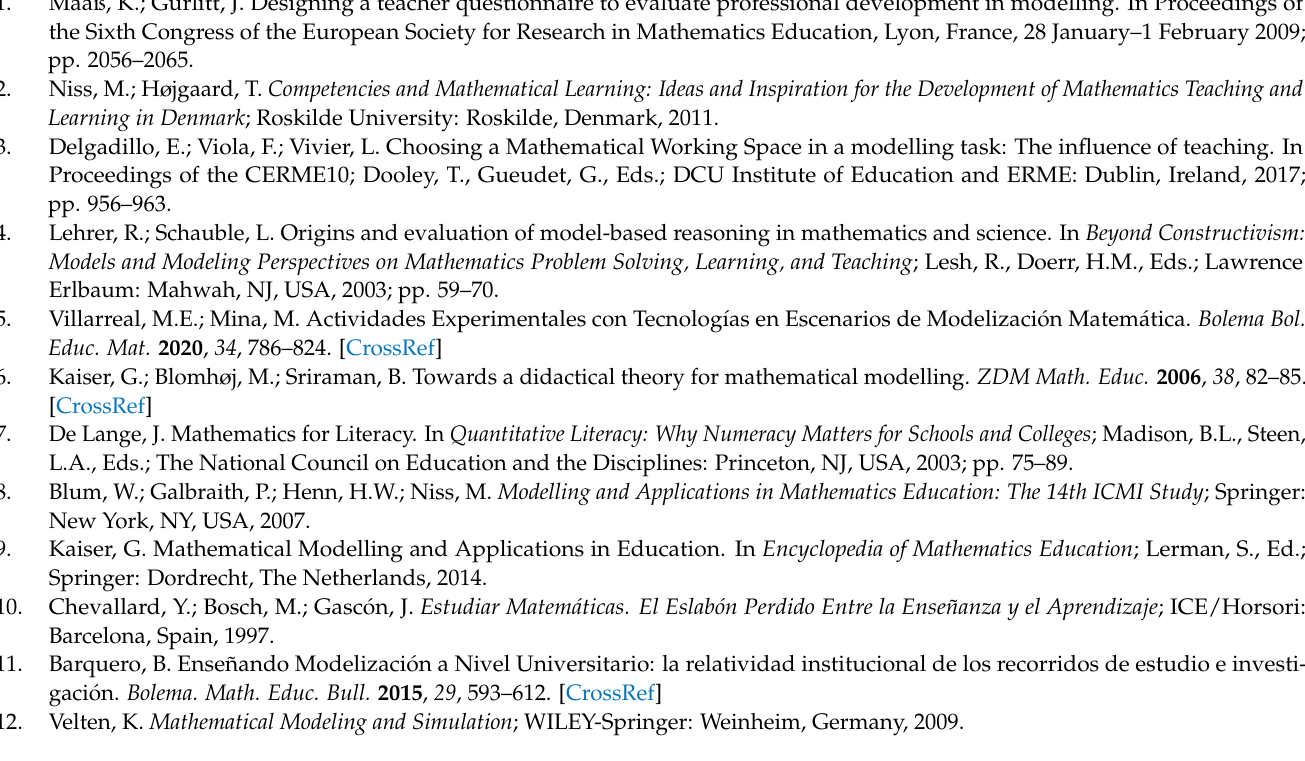
Figure A6. Translation into English of the written production for the task “the play center”. Answer to question c) (source: prepared by the authors).